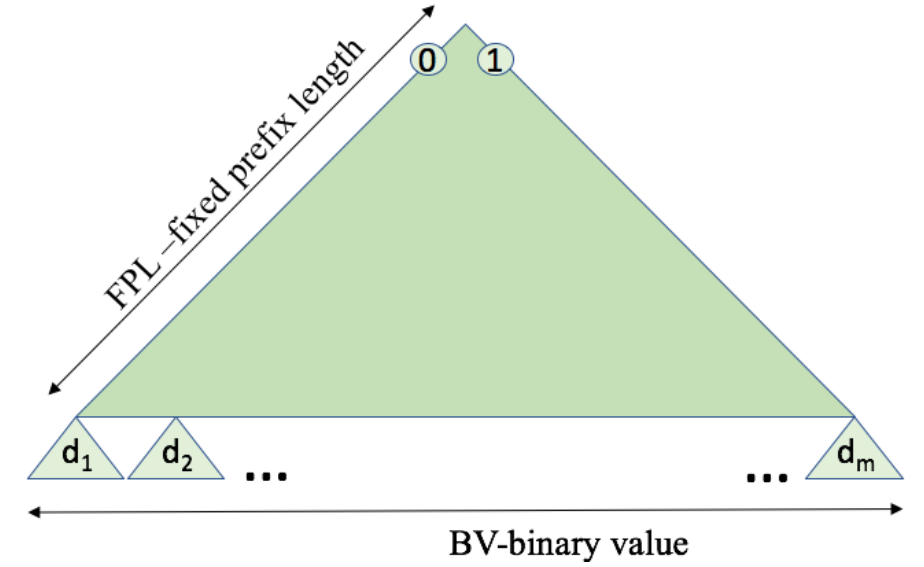
Figure 4. Types of tag ID